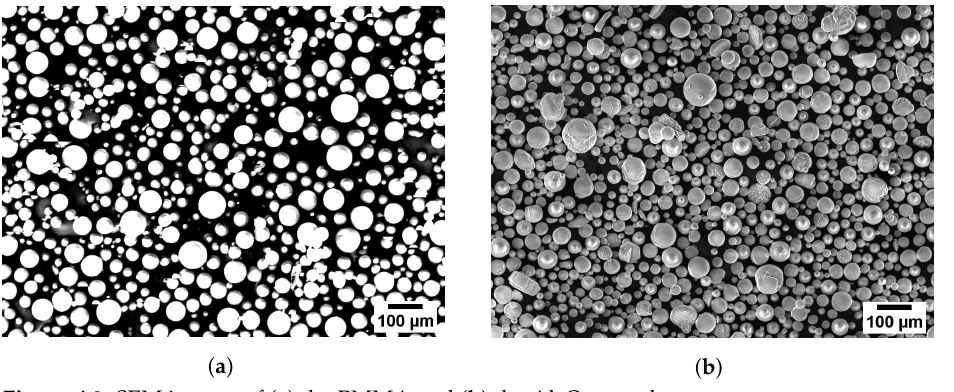
Figure A2. SEM images of ( a ) the PMMA and ( b ) the Al 2 O 3 powder.